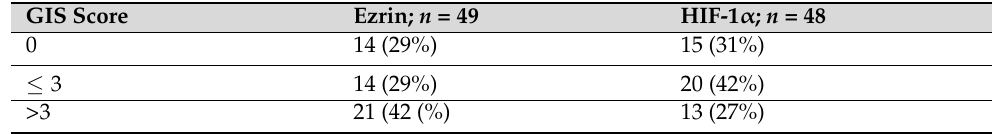
Table 2. Ezrin and HIF-1 α expression in primary melanoma.